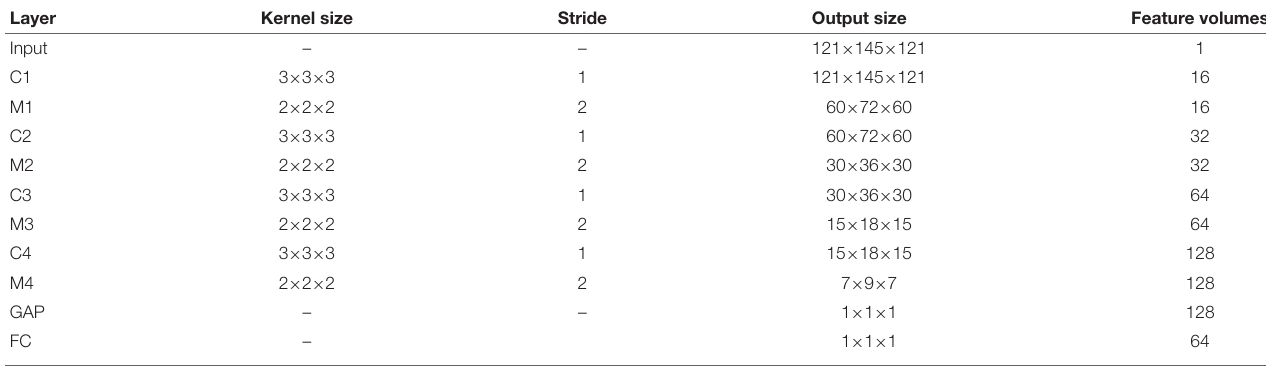
TABLE 2 | Architecture of the CNN module in the proposed AMINI framework. Layer Kernel size Stride Output size Feature